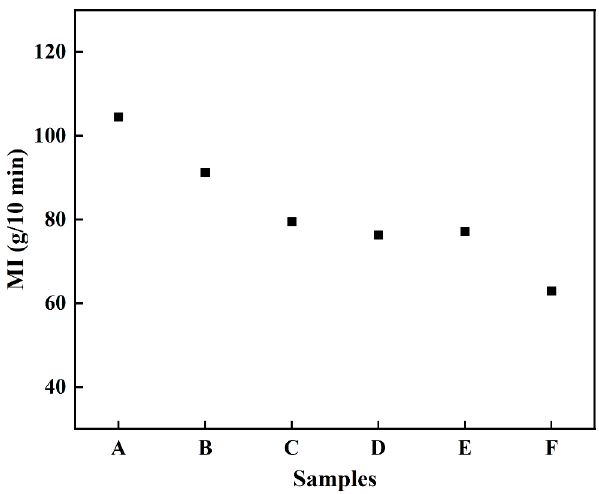
Figure 2. Melt index of sample A–F with different coupling media.